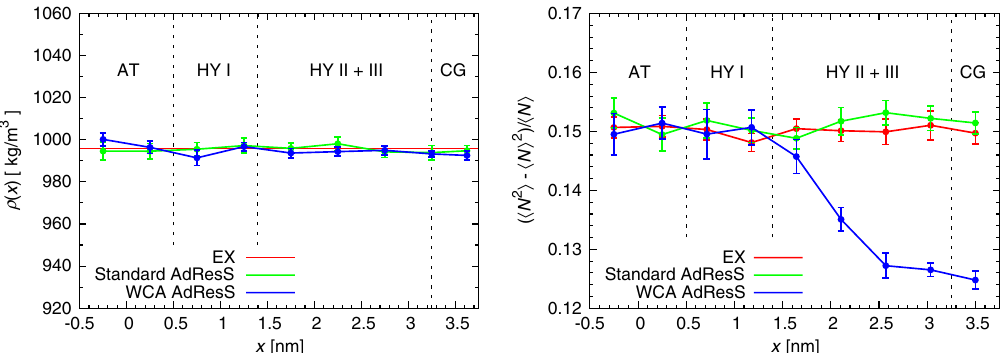
FIG. 5. Density and fluctuation profiles of the case of the WCA potential in AdResS. The results are compared with the EX and the standard AdResS. The error bars indicate the statistical error up to a confidence level of 95% .